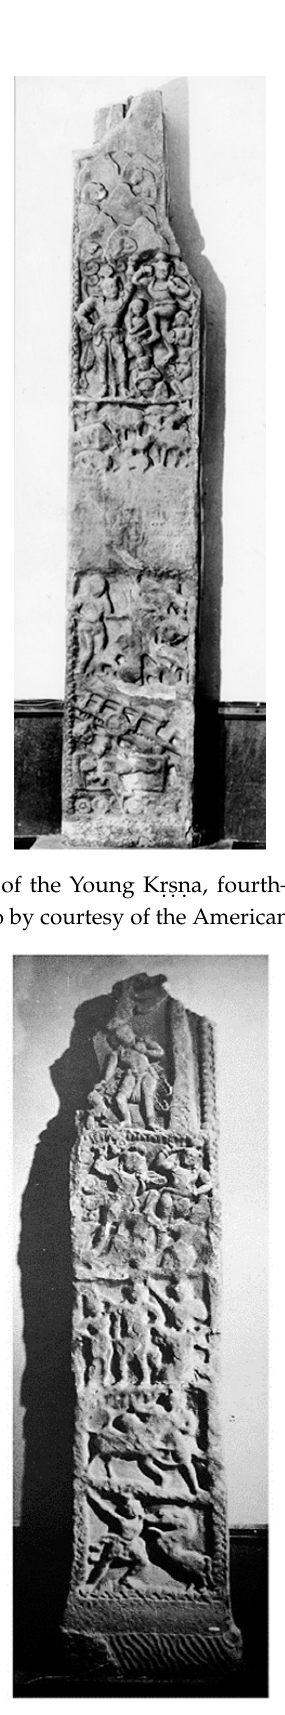
Figure 4. Detail of Figure 2: Churning of the Butter. A woman stands on the left, facing the viewer. She is busy churning the contents of a big pot placed at her feet with a rope; below her legs, a kneeling child raising his face towards her and in the